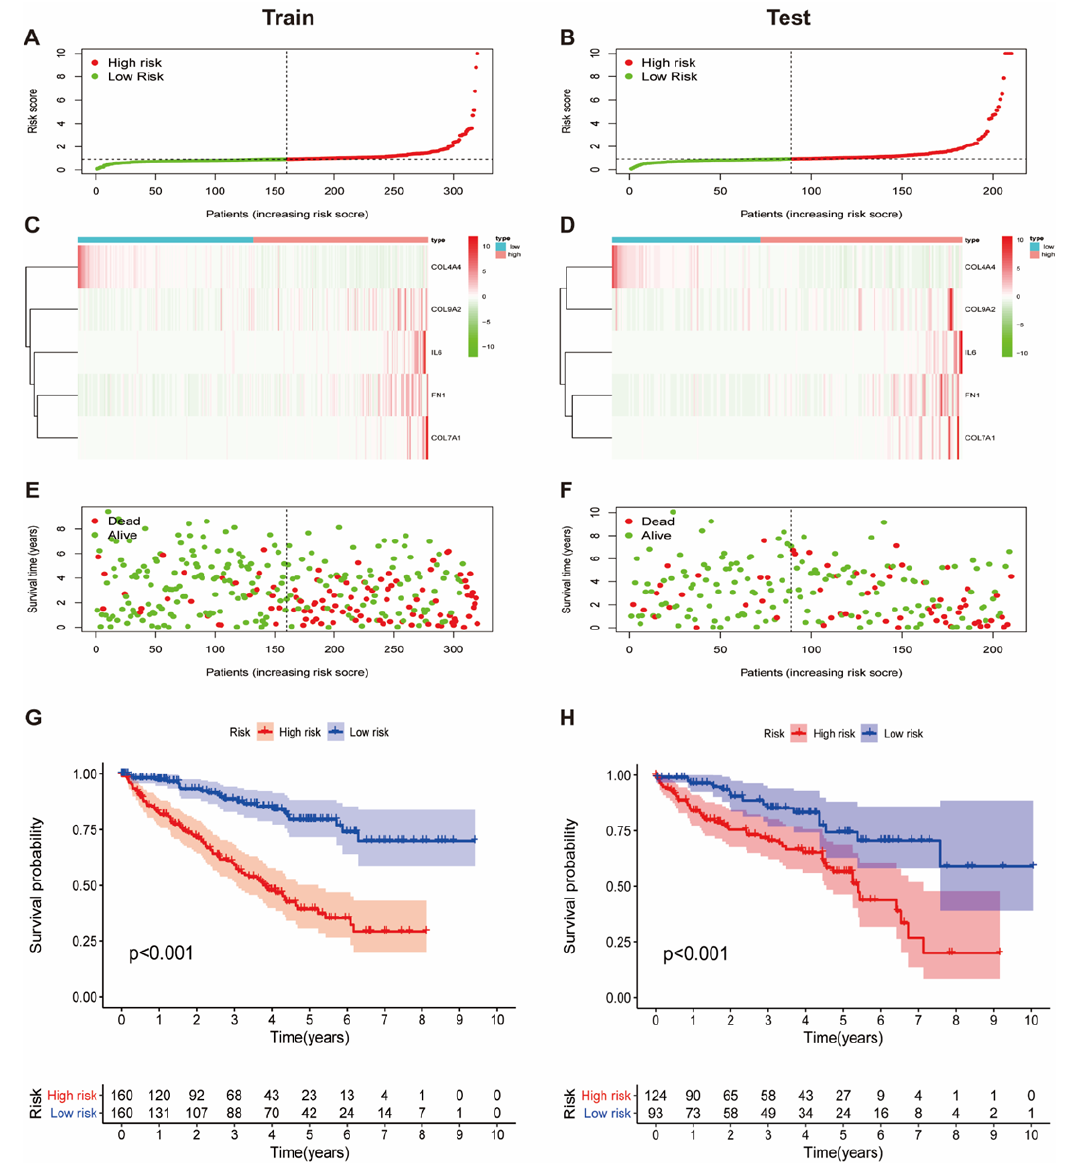
Figure 3. Prognosis value of collagen-related signature in train and test cohort. ( A , B ) Risk curve of ccRCC patients in train and test cohort. The median risk score in train cohort was set as the cutoff value to separate patients into high and low risk groups. The cutoff value in train cohort was also used to calculate the risk score of patients in test cohort; ( C , D ) The heatmap showing five hub gene expression profiles in high and low risk groups from train and test cohort; ( E , F ) Patient status distribution in high and low risk groups; ( G , H ) The Kaplan – Meier overall survival curves for patients assigned to high and low risk groups based on the risk score.